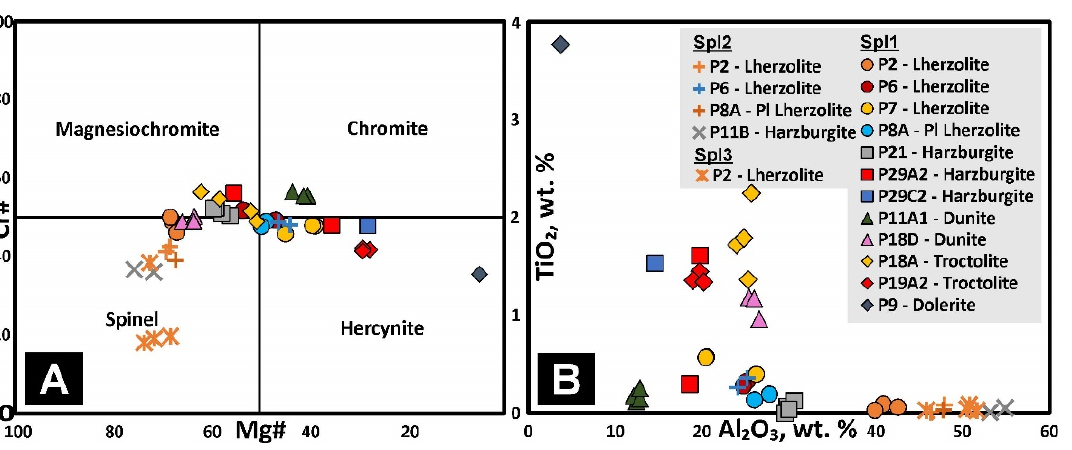
Figure 20. Spinel group chemistry. ( A ) Relationship between Mg# = [Mg/(Mg + Fe 2+ ) × 100] atomic ratio and Cr# = [Cr/(Cr + Al) × 100] atomic ratio. ( B ) Relationship between Al 2 O 3 and TiO 2 spinel content (in wt.%). The individual spinel ‐ group end ‐ member mineral terminology is from [54].